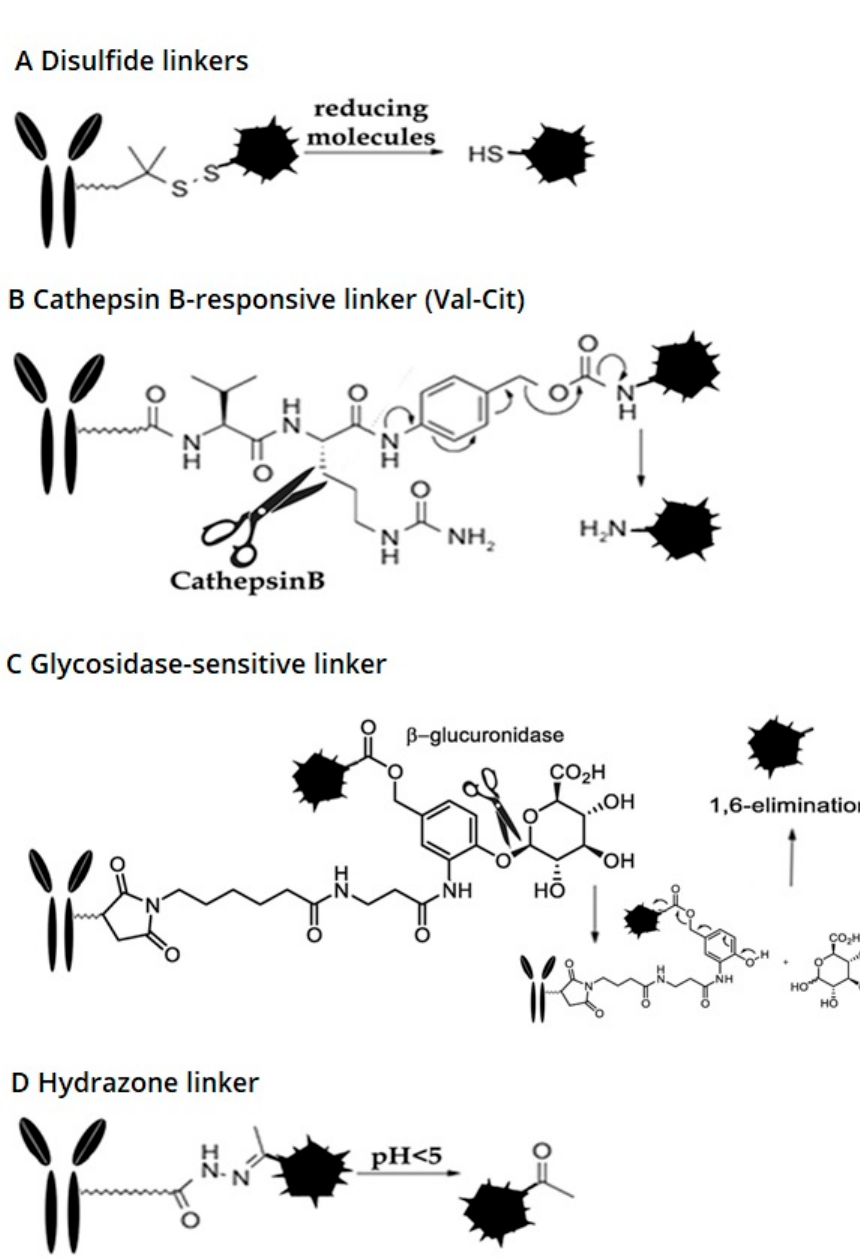
Figure 3. Available cleavable linkers in ADC ( A ) Disulfide linker, cleaved by reducing agents; ( B ) cathepsin B responsive linker, cleaved by Cathepsin B; ( C ) glycosidase-sensitive linker, cleaved by gluconidase; ( D ) hydrazone linker, cleaved by acidic environment.